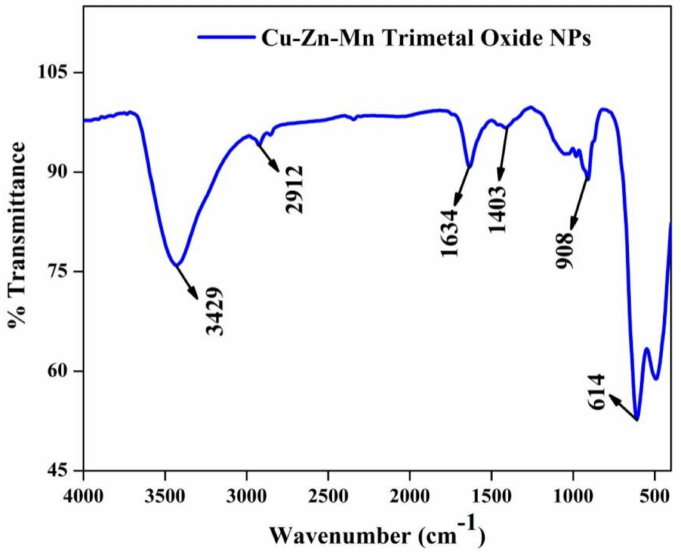
Figure 9. FT-IR of Cu-Zn-Mn mixed trimetal oxide